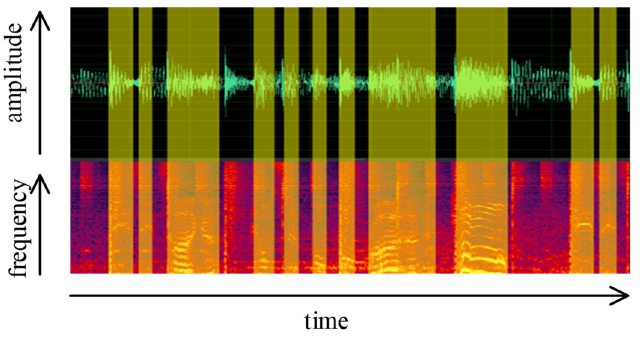
Figure 1. An illustration of singing voice detection. The upper image is the waveform of a music clip, and the lower image is the spectrogram.